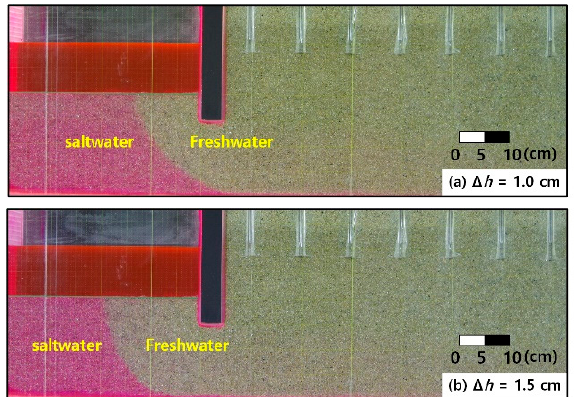
Figure 3. Pressure-equilibrium state between saltwater (red) and freshwater (light green) in a sandy tank for h = 10 cm and Δ S = 35 psu at Δ h of ( a ) 1 cm and ( b ) 1.5 cm.